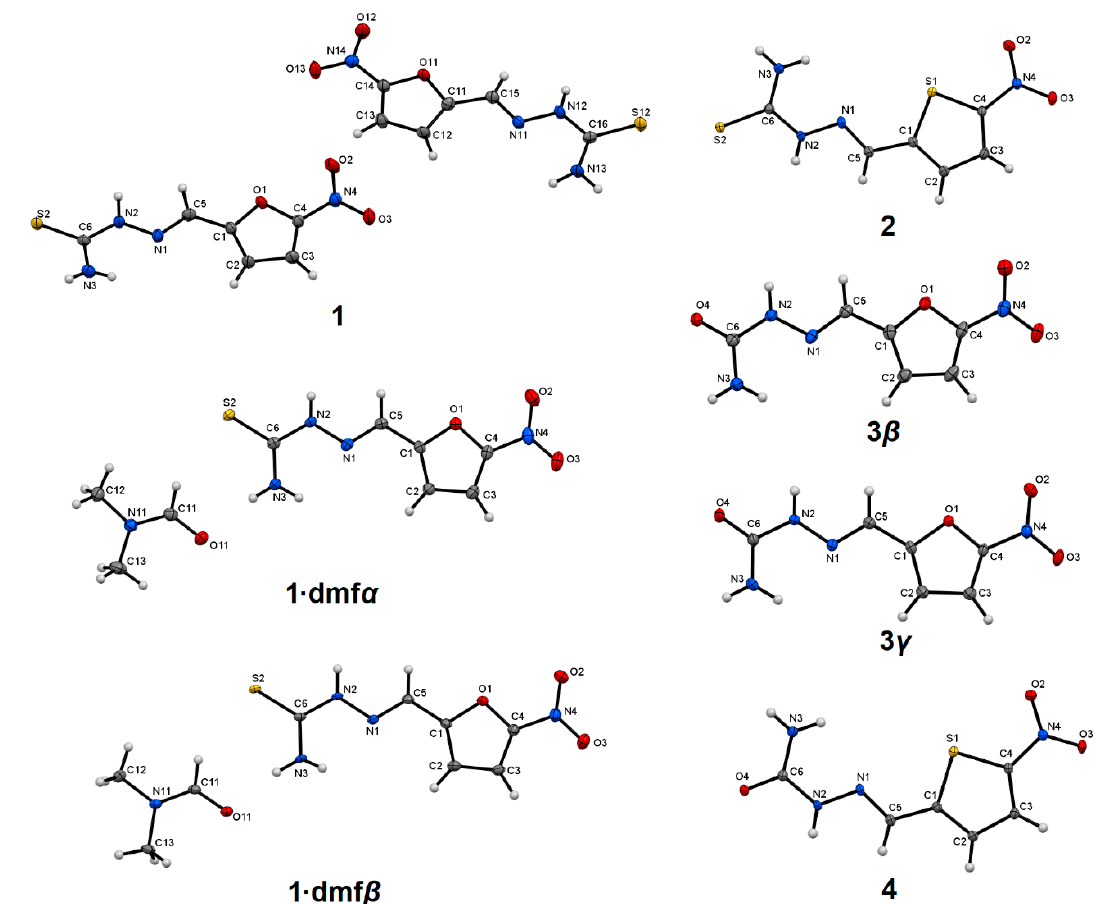
Figure 1. Solid state structures of the studied compounds with the atom numbering scheme, plotted with a 50% probability of displacement ellipsoids of non-hydrogen atoms. Hydrogen atoms are plotted as spheres of arbitrary radii.